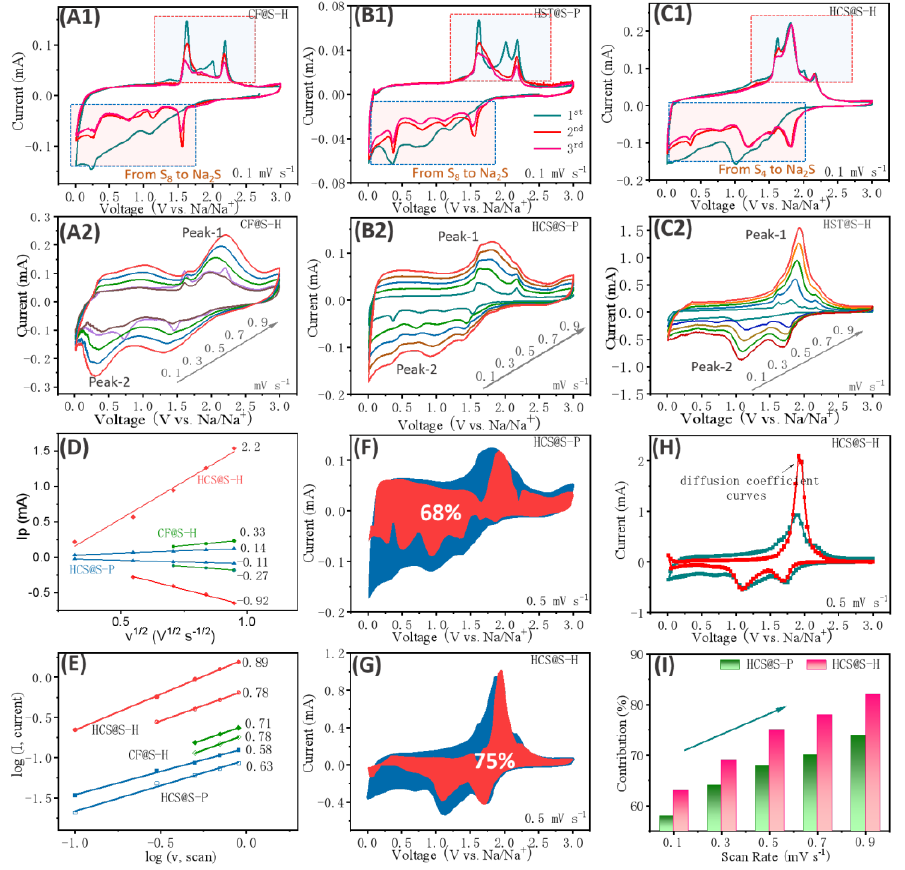
Figure 5. The analysis of kinetic behaviors: CV curves at 0.1 mV s -1 and different scan rates for CF@S-H ( A1 , A2 ), HCS@S-P ( B ), HCS@S-H ( C ), the linear relationship of peak-current and v 1/2 ( D ), log (i) and long (v) ( E ), the pseudo-capacitive contributions area at 0.5 mV s -1 for HCS@S-P ( F ) and HCS@S-H ( G ), the diffusion coefficients about the full curves about HCS@S-H ( H ) and the surface-controlling capacity contribution at different scan rates ( I ).